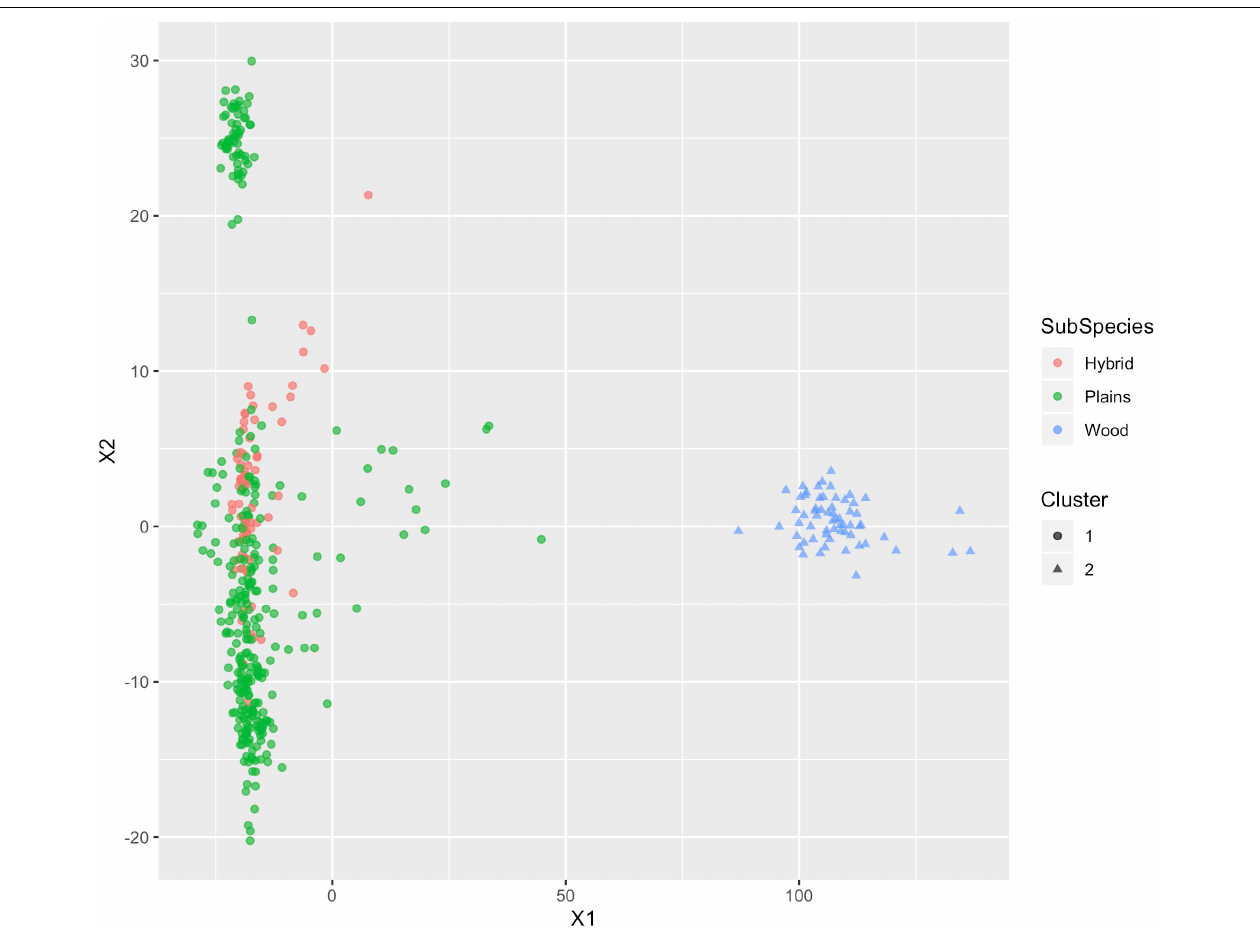
Genome Composition